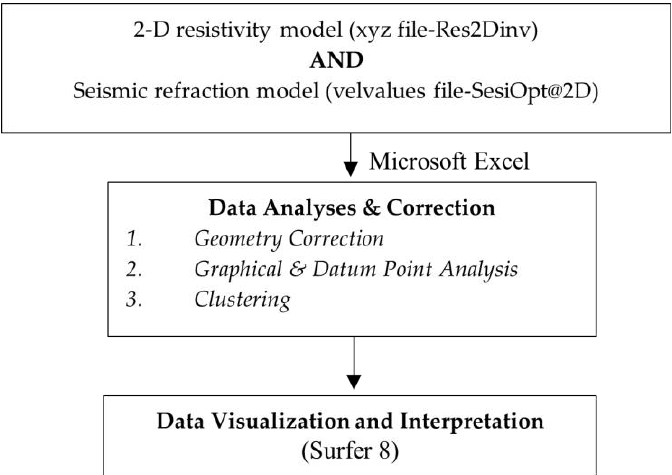
Figure 5. The workflow of cross-plot analysis and development of the 2-D model.